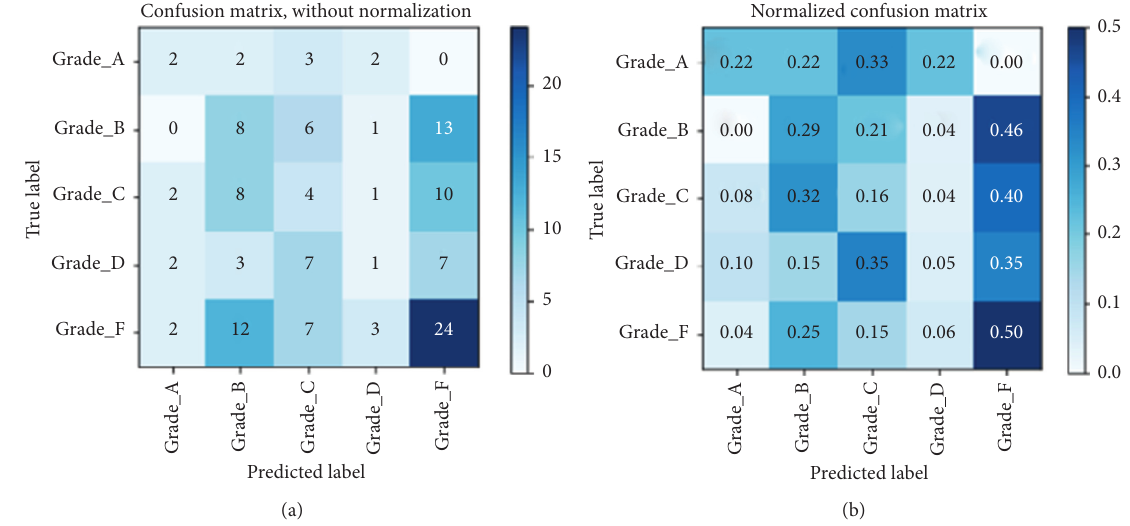
Figure 10: Confusion matrices of M-learning model 3, without normalization and normalized confusion matrix. (a) Without